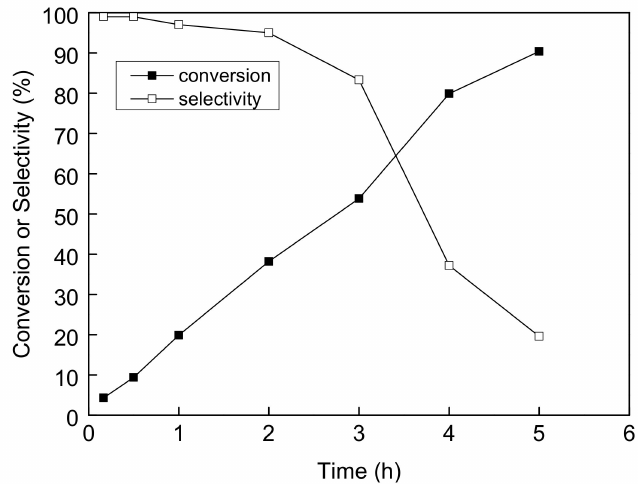
Figure 5. The conversion of benzyl alcohol and selectivity of the. benzaldehyde for the benzyl alcohol oxidation over Ca(II) coordination polymer catalyst with THF as solvent at 130 ◦ C under 1 MPa O 2 .